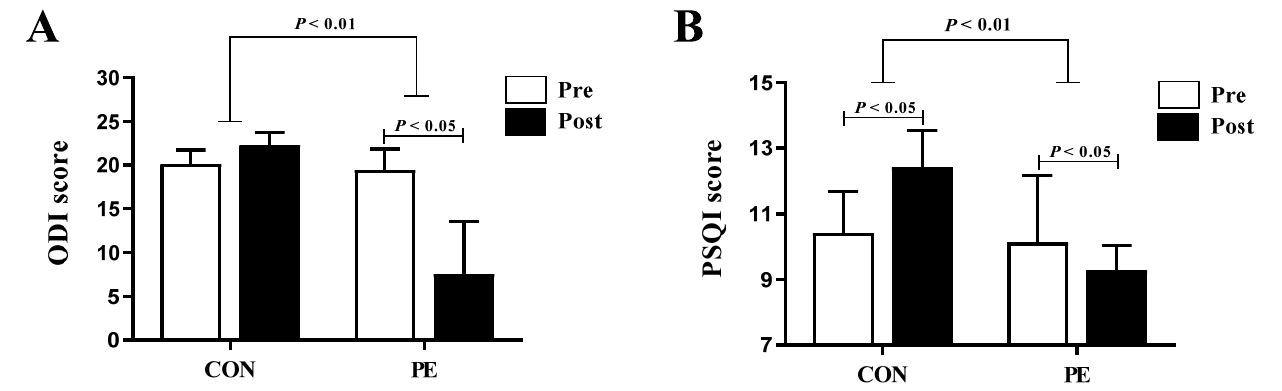
Figure 2. HTPE reduced ODI and PSQI score in Korean pregnant woman. ( A ) ODI score and ( B ) PSQI score ( n = 7 per group). Error bars represent mean ± SD. CON: non-pilates exercise, PE: Pilates exercise, ODI: Oswestry Disability Index, PSQI: Pittsburgh Sleep Quality Index.